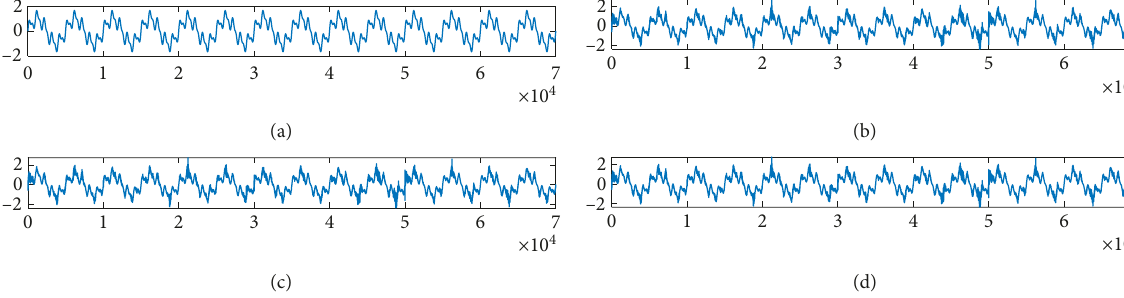
0.001, (c) α 0.005, and (cid:29) (cid:29)